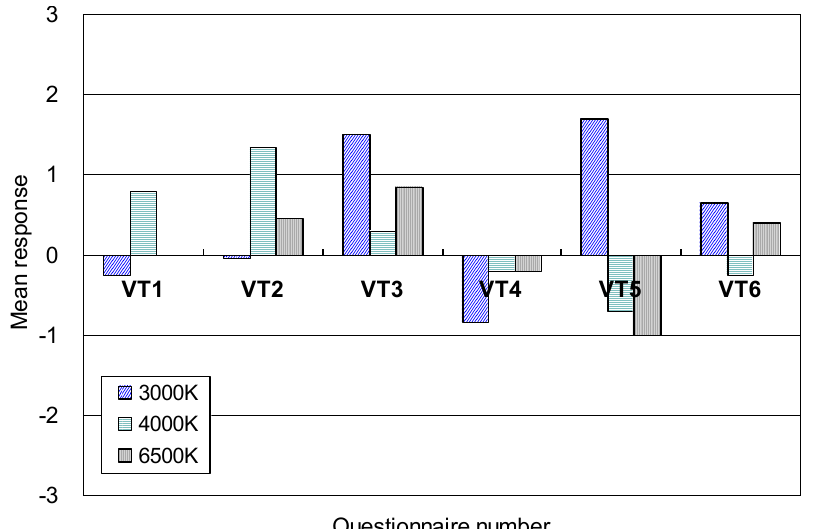
Figure 17. Perception of visual stimulation (750 lx conditions, Computer